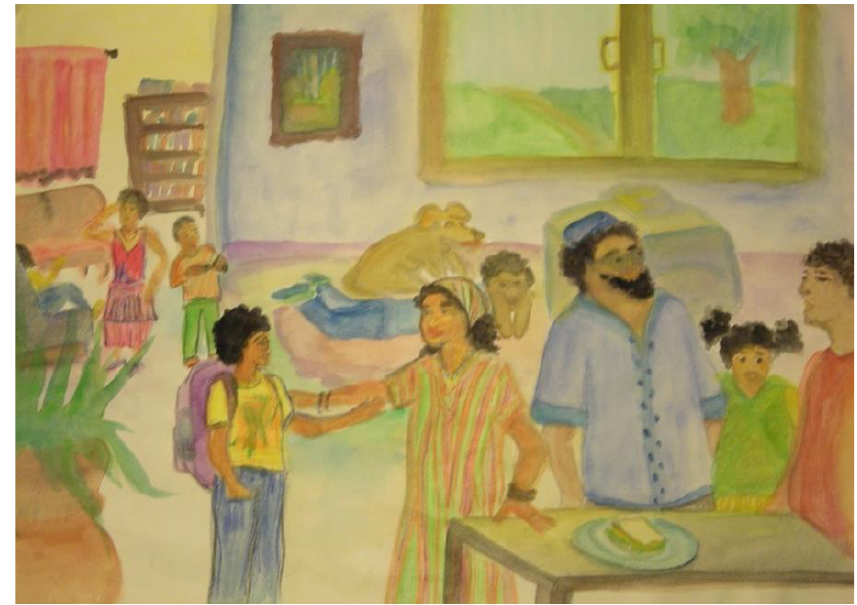
Figure 7. Kinetic Family Drawings with teens — cultural considerations of FOO.